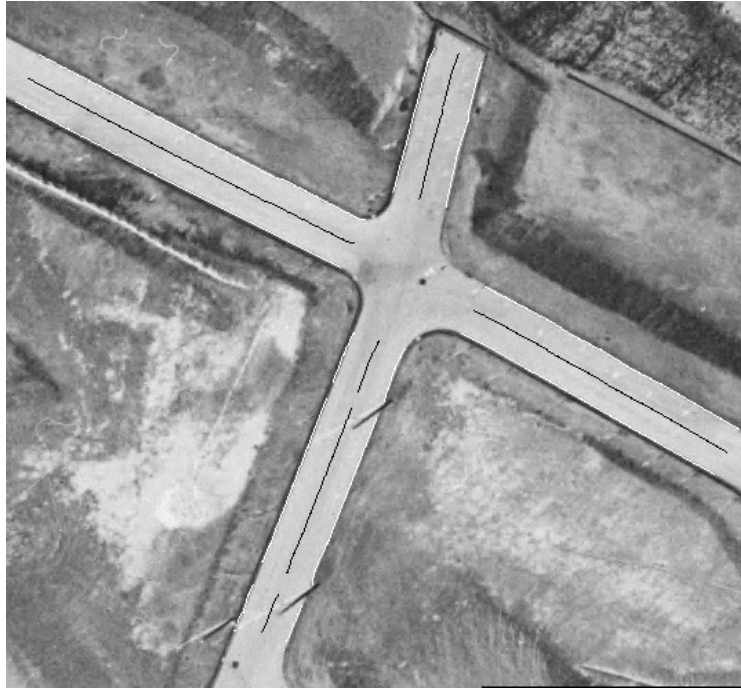
Fig. 10 – Results obtained for the high-resolution image 1.